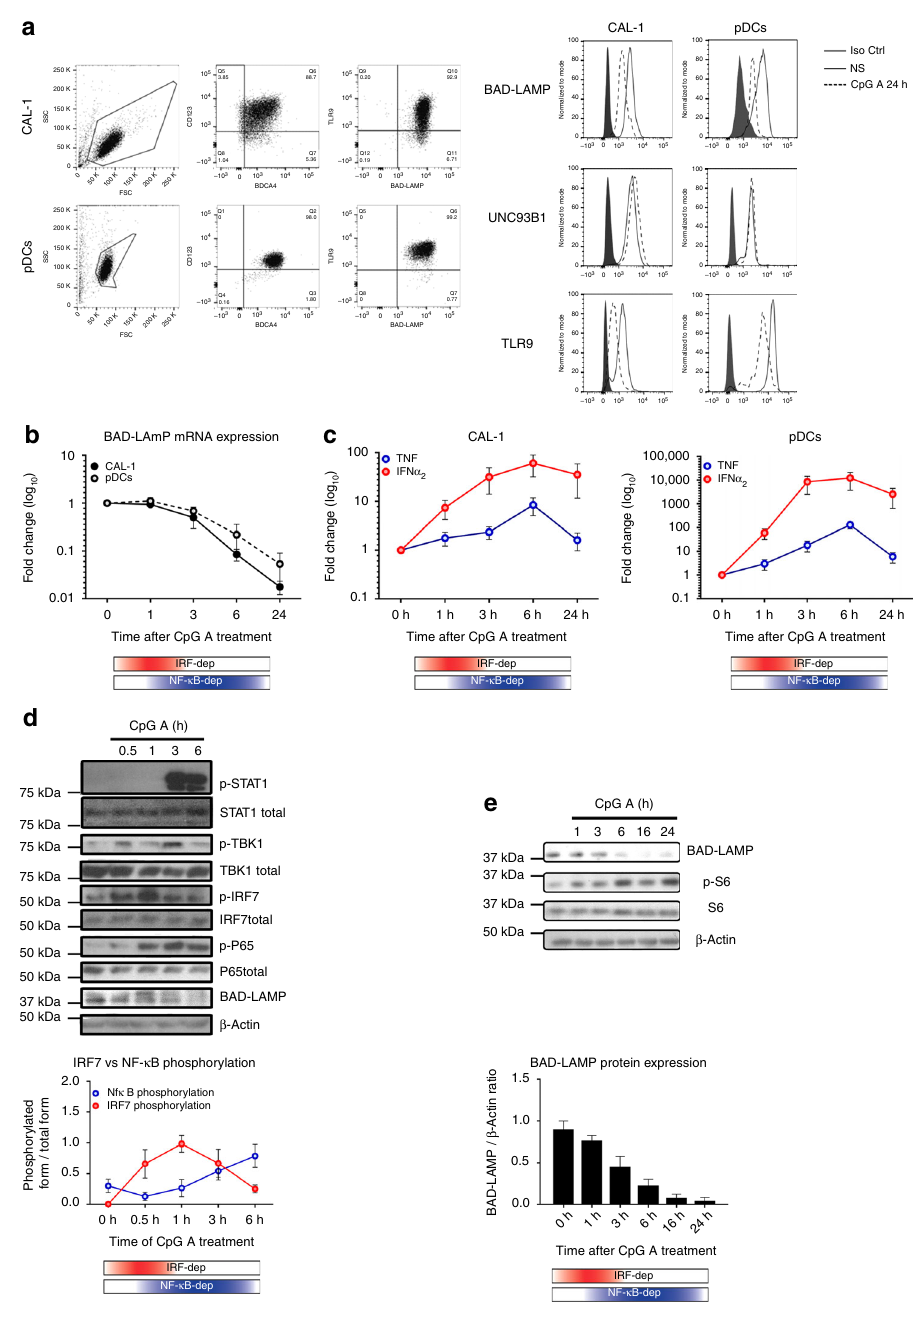
NATURE COMMUNICATIONS | 8: